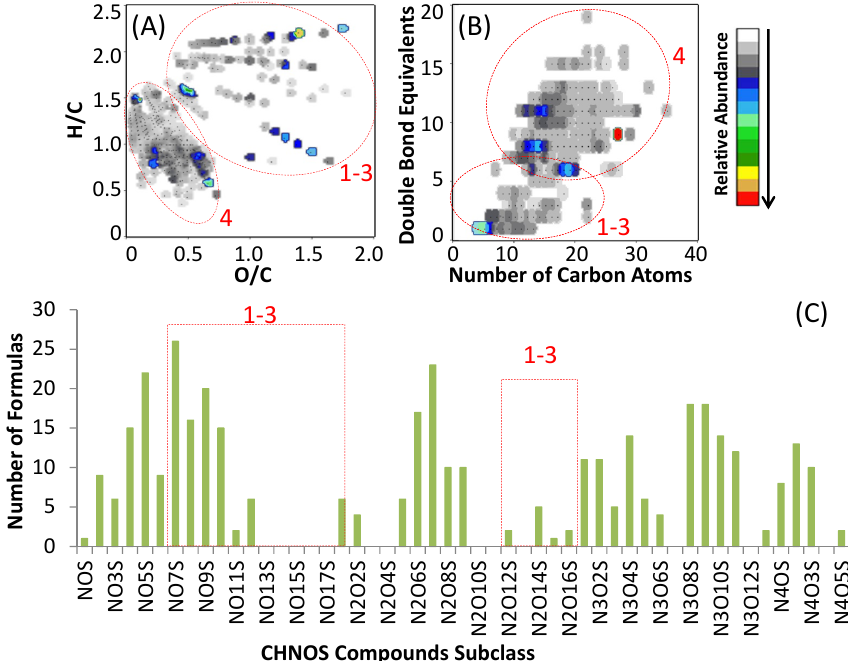
Fig. 7. Isoabundance van Krevelen diagram for CW1 CHNOS compounds (a) . Isoabundance plot of DBE vs. number of carbon atoms in molecular formulas for CW1 CHNOS compounds (b) . Number of formulas identified in each of CW1 CHNOS subclasses (c) . The red circles indicate the approximate groupings (1 to 4) of the CW1 CHNOS formulas. The bars not boxed in (c) belong to group 4. The corresponding figures for CW2 CHNOS compounds are shown in Fig.